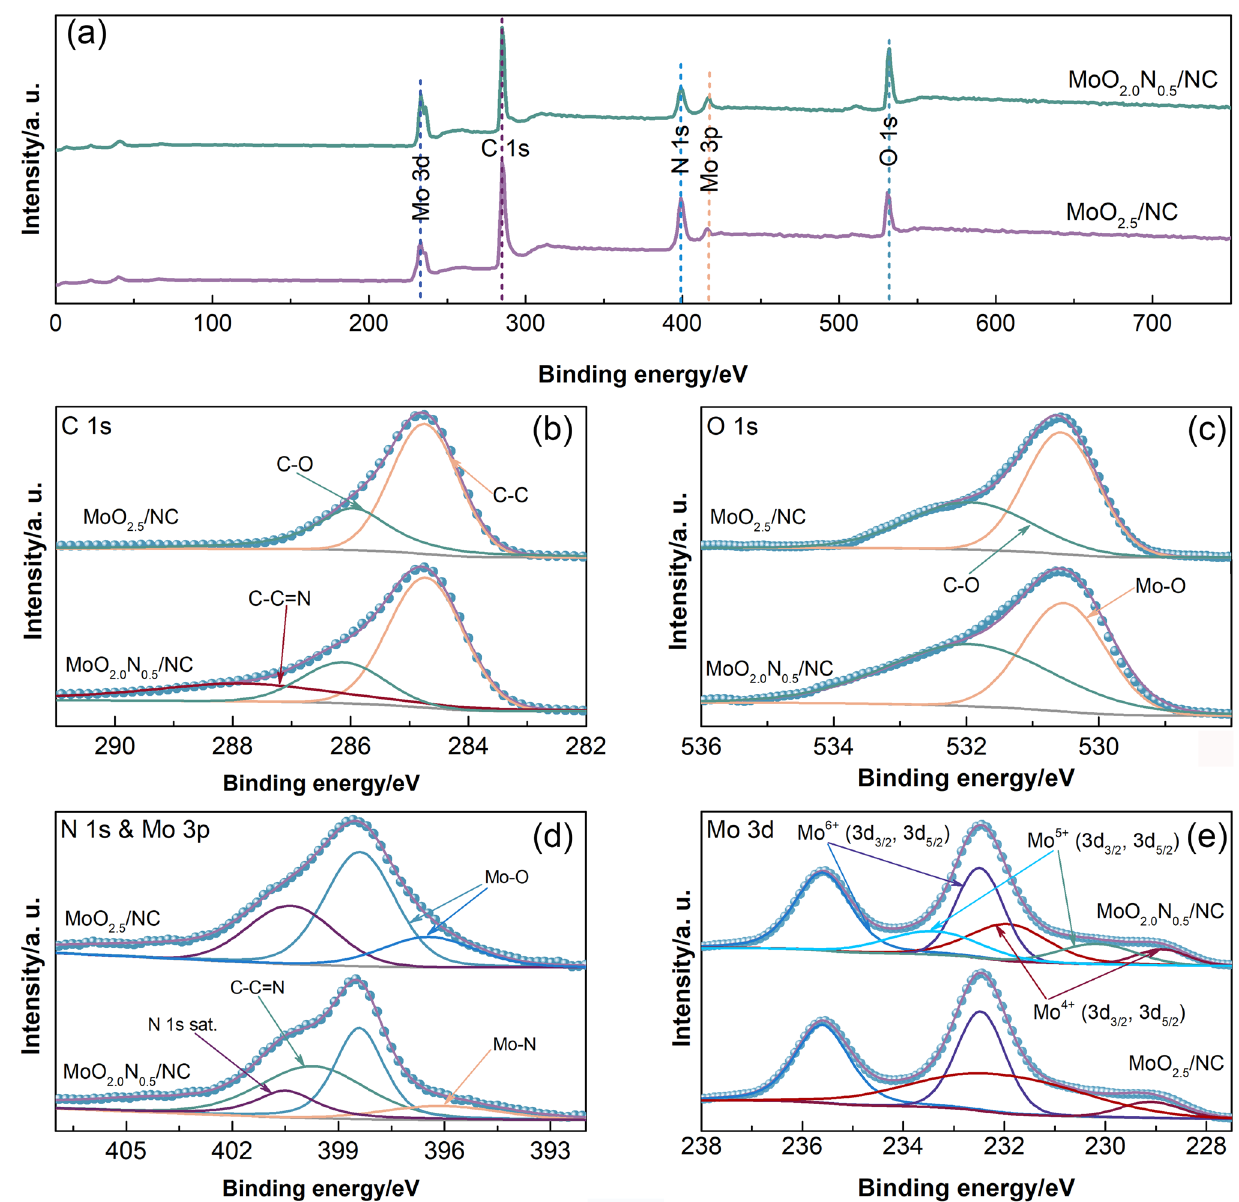
Fig. 3 a XPS spectra of MoO 2.5 /NC and MoO 2.0 N 0.5 /NC; high-resolution XPS spectra of C b 1 s , c O 1 s , d N 1 s & Mo 3 p , and e Mo 3